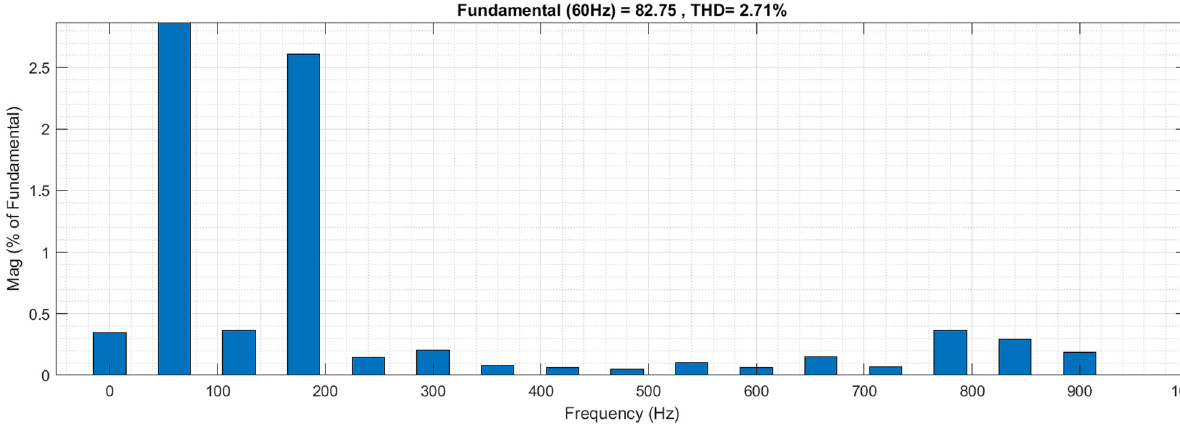
Figure 10: i abc THD. Scenario 2 ( proposed method ) – connection to an unbalanced power grid.